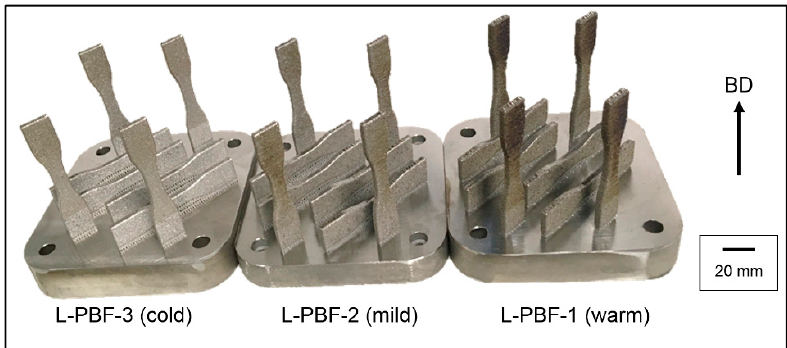
Figure 2. Building platforms for L-PBF-1, 2, and 3 with tensile specimens.